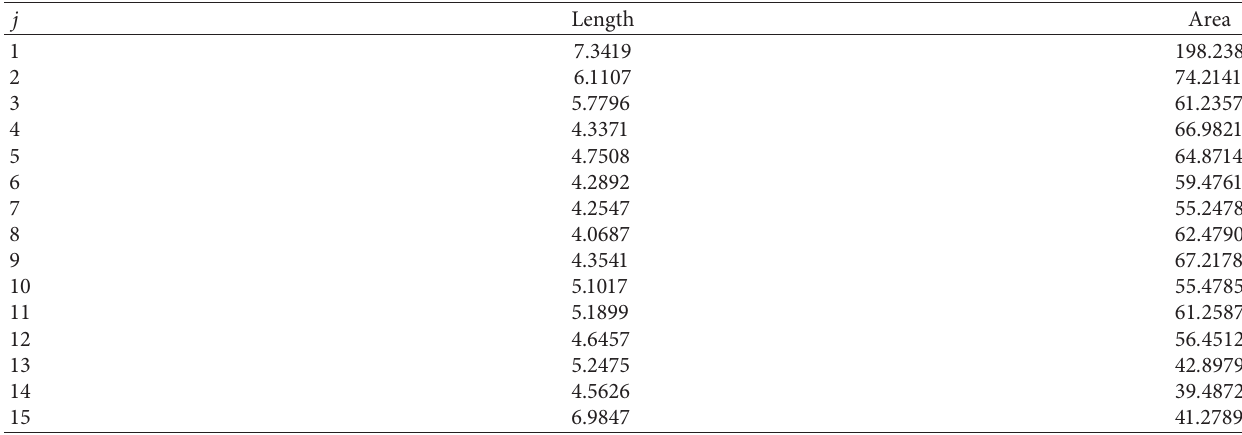
Table 4: The interval lengths for β and 95% confidence area for α and β